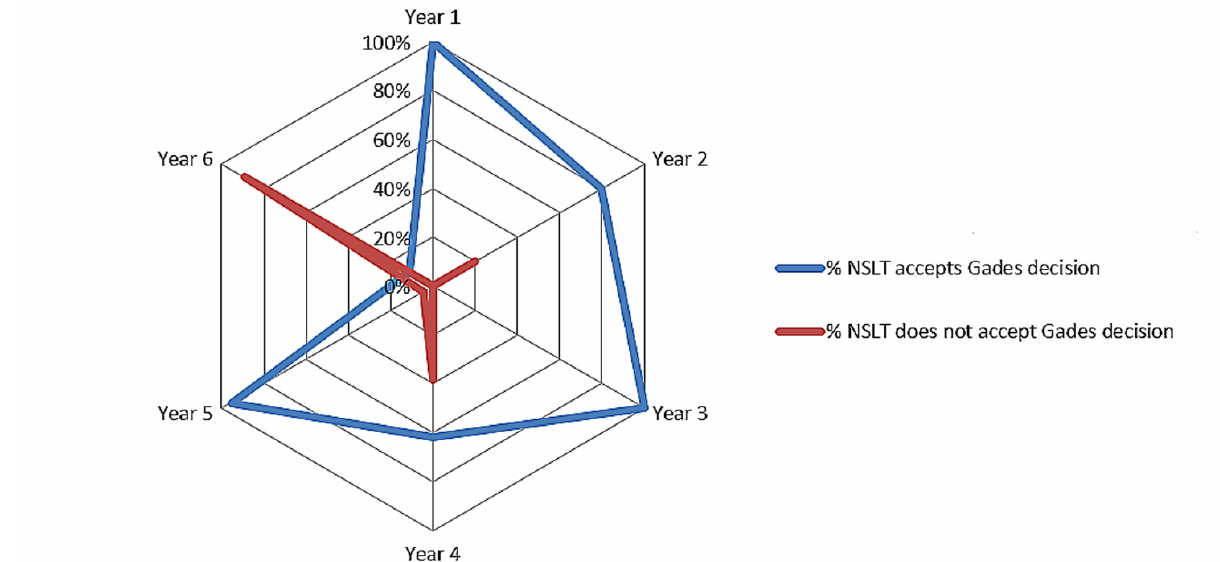
Figure 4. Knowledge base accuracy by age of the